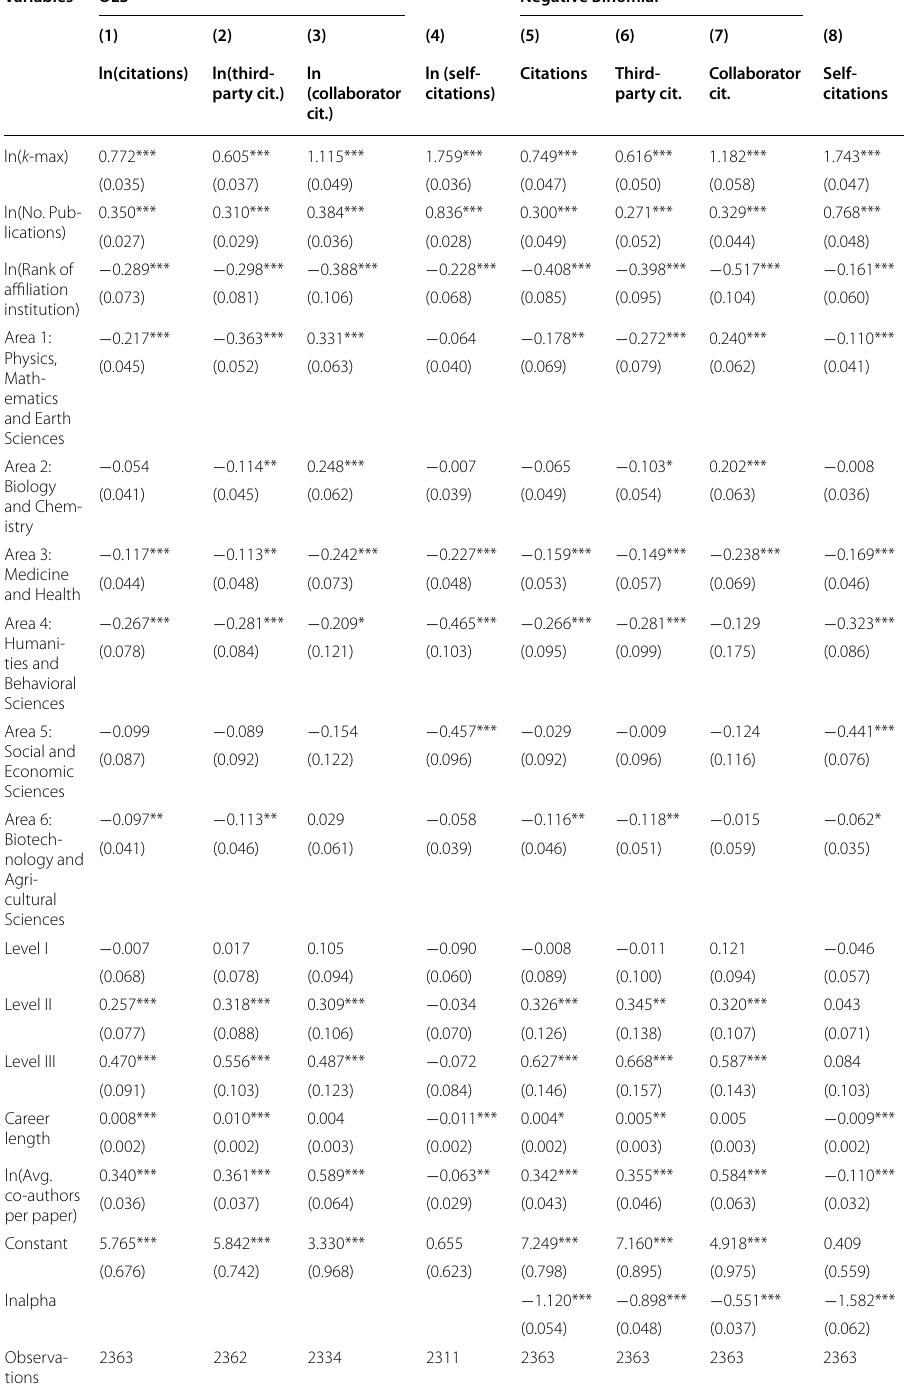
Table 3 Effect of individual and network characteristics on ln(citations) of an author